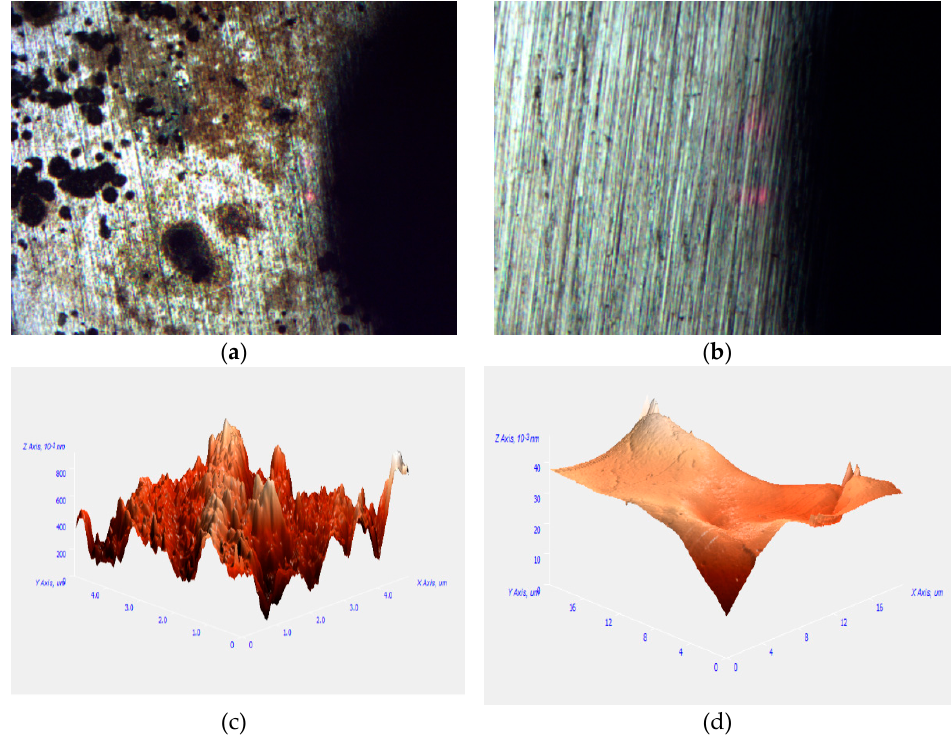
Figure 9. Optical image ( a ) copper surface in a 3.5% NaCl solution ( b ) copper surface coated with GG-AMPS in a 3.5% NaCl solution; AFM images ( c ) copper surface in a 3.5% NaCl solution ( d ) copper surface coated with GG-AMPS in a 3.5% NaCl solution .